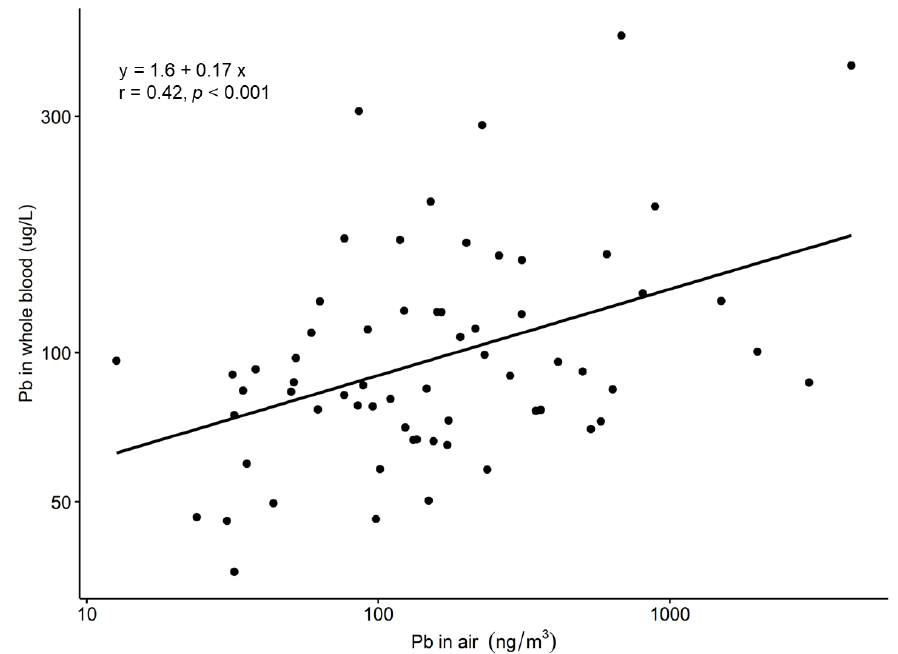
Figure 3. The association between the concentrations of Air-Pb and B-Pb ( n = 64). The regression equation and Pearson’s correlation coefficient are shown in the figure.